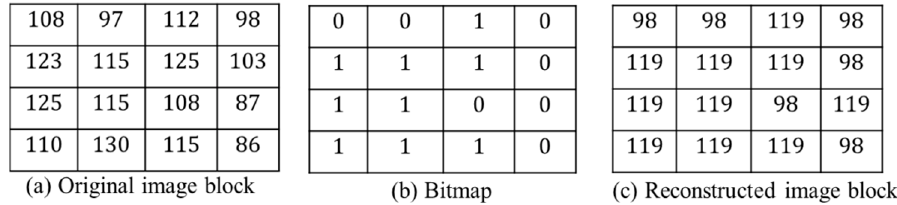
Figure 1. Example of absolute block truncation coding (AMBTC) encoding procedures.